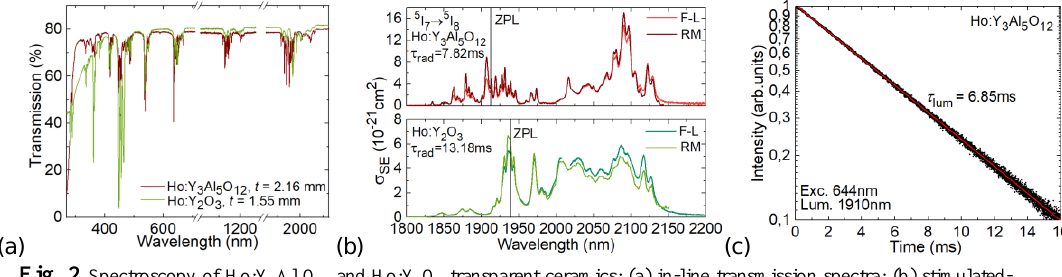
Fig. 2 Spectroscopy of Ho:Y 3 Al 5 O 12 and Ho:Y 2 O 3 transparent ceramics: (a) in-line transmission spectra; (b) stimulated- emission, σ SE , cross-sections for the 5 I 7 → 5 I 8 transition calculated by the Füchtbauer–Ladenburg (F-L) equation and reciprocity method (RM); (c) luminescence decay curve from the 5 I 7 Ho 3+ state for the Ho:Y 3 Al 5 O 12